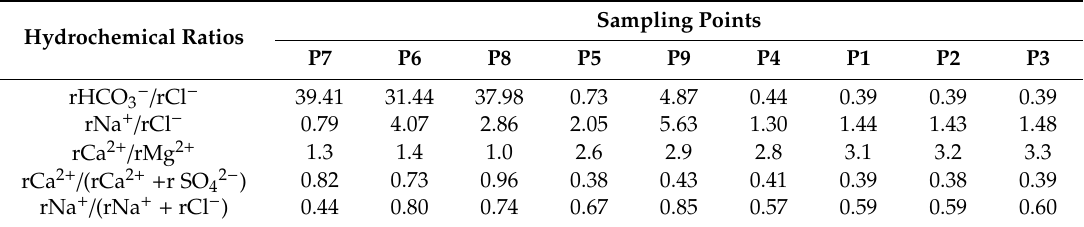
Table 4. The hydrochemical ratios values for individual sampling points ordered by location from North to